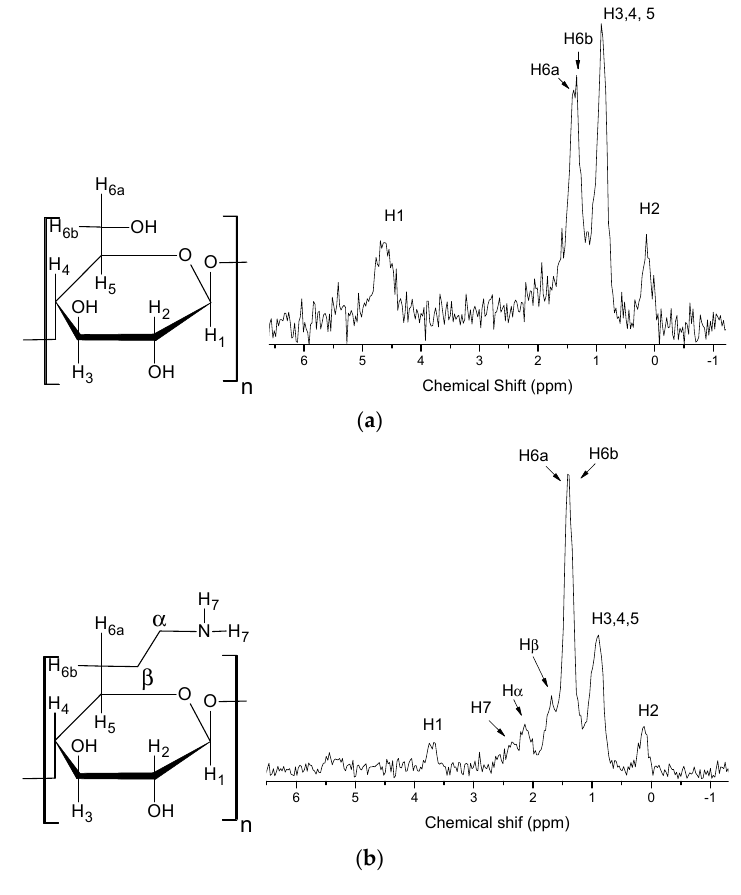
Figure 3. Solid state 1 H-NMR spectra of pristine microcrystalline cellulose ( a ) and CN polymer ( b ). The solid state 1 H-NMR spectrum of the CN cellulose in Figure 3b shows changes in cellulose